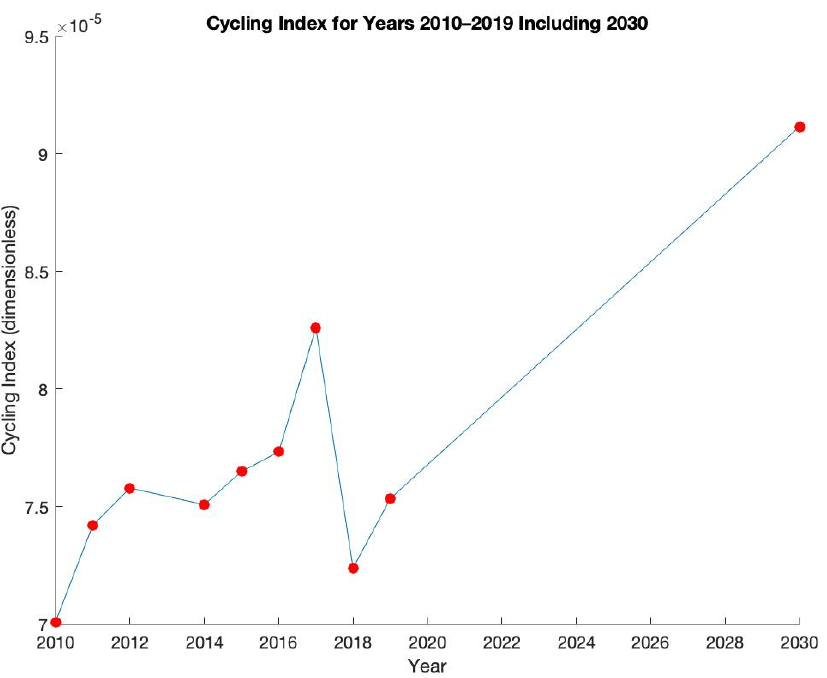
Figure 10. Cycling indices for Maryland’s energy industry from 2010–2019 including 2030.